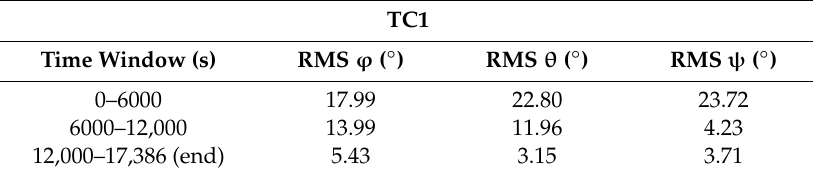
Table 10. Root Mean Square of the attitude estimation errors for Hardware-in-the-Loop simulation of Test Case 1.